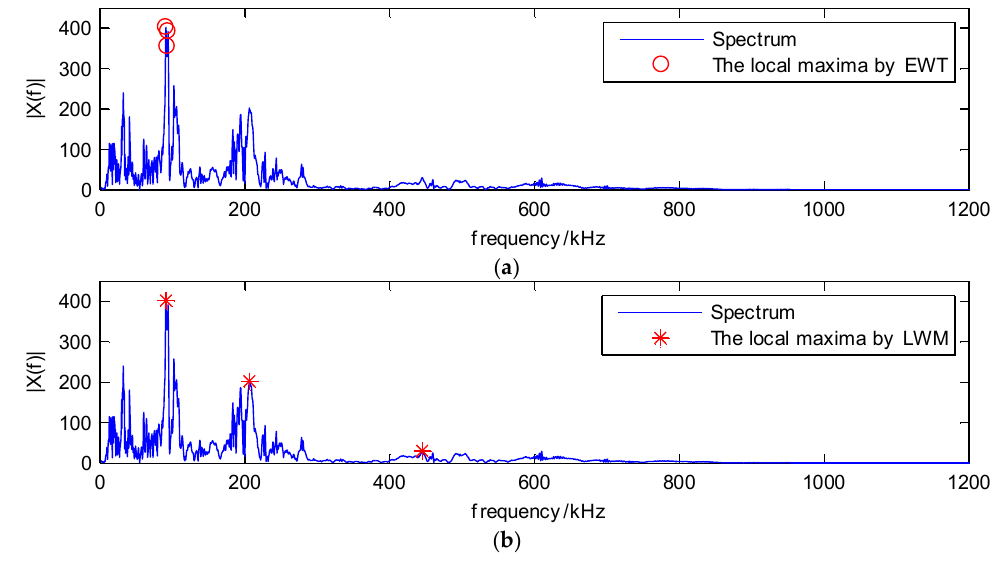
Figure 13. Local maxima of ( a ) the original EWT method and ( b ) the proposed LWM method.